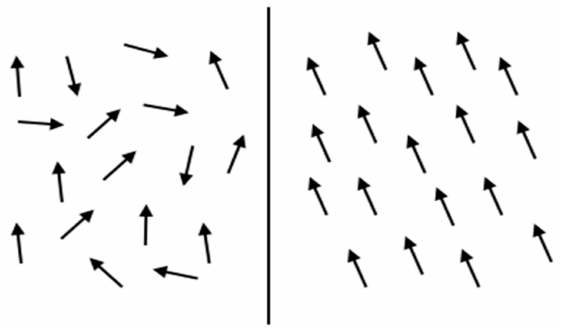
Figure 3. Disorder and order of phenomenal telos. For a disordered phenomenon (left) there is no discernible regularity of motion to be found in the constituent elements of the system as a whole. Consequently, disordered phenomena do not produce far-from-equilibrium emergent order. For an ordered phenomena (right) there is a discernible regularity of motion (a type of ‘pattern’) that operates on particular rules or logics which enable the phenomenon to dynamically maintain itself over the course of time (e.g., biological information of DNA, linguistic information of language are good examples of ordered phenomenon that maintain themselves with particular rules or logics). Consequently, ordered phenomenon are capable of producing emergent phenomena that are in turn